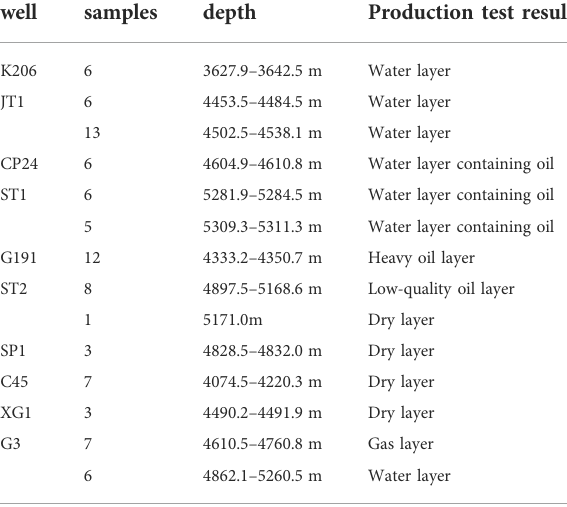
TABLE 1 Core samples from the P 3 w